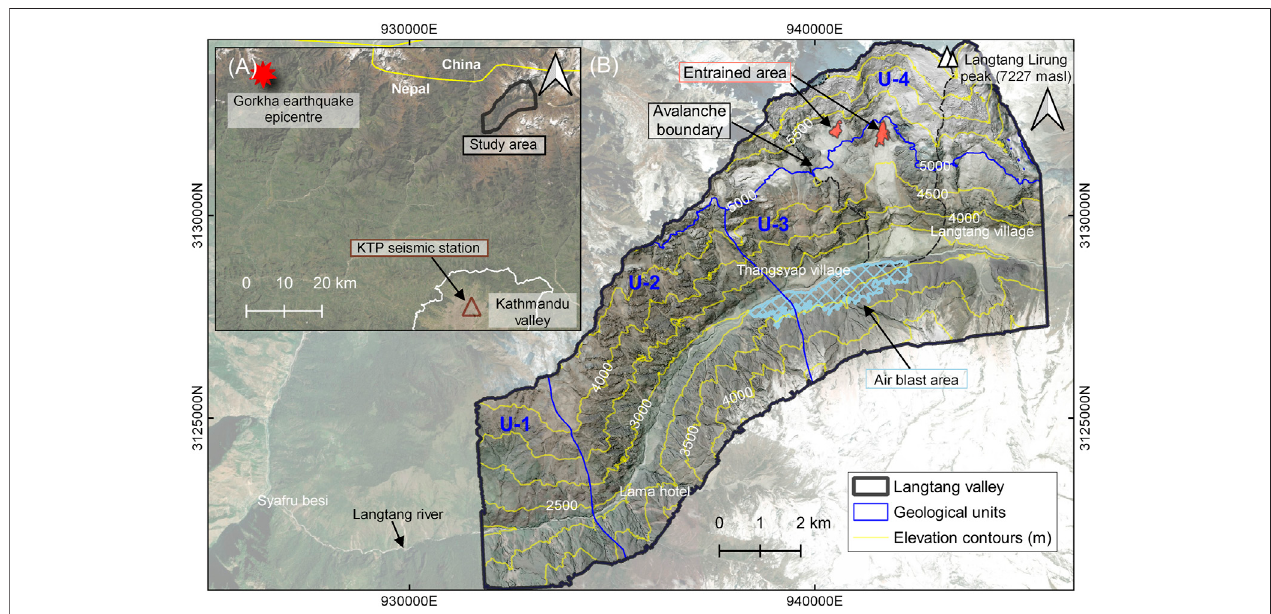
FIGURE 1 | Map of Langtang valley. (A) Study area lies approximately 60 km north of Kathmandu. The red star shows the epicenter of the 2015 Gorkha earthquake. (B) Langtangvalleytopographyindicatedbyyellowelevationcontours.Thebluelinesareboundariesofgeologicalunits(Jonesetal.,2020),U-1(Syaprubesi formation), U-2 (Bamboo formation), and U-3 (Langtang formation). U-4 is above the permanent snowline at 5,000 masl and consists of glacier ice and snow. The black dashedlineshowsthecatastrophicLangtangavalancheboundarythatoriginatedabove5,000maslanddescendedontoLangtangvillageat ∼ 3,400masl.Thered polygons are the avalanche ’ s entrainment areas (Gnyawali et al., 2020). The blue hatched polygon is the air-blast impact area on the opposite slope of the valley.